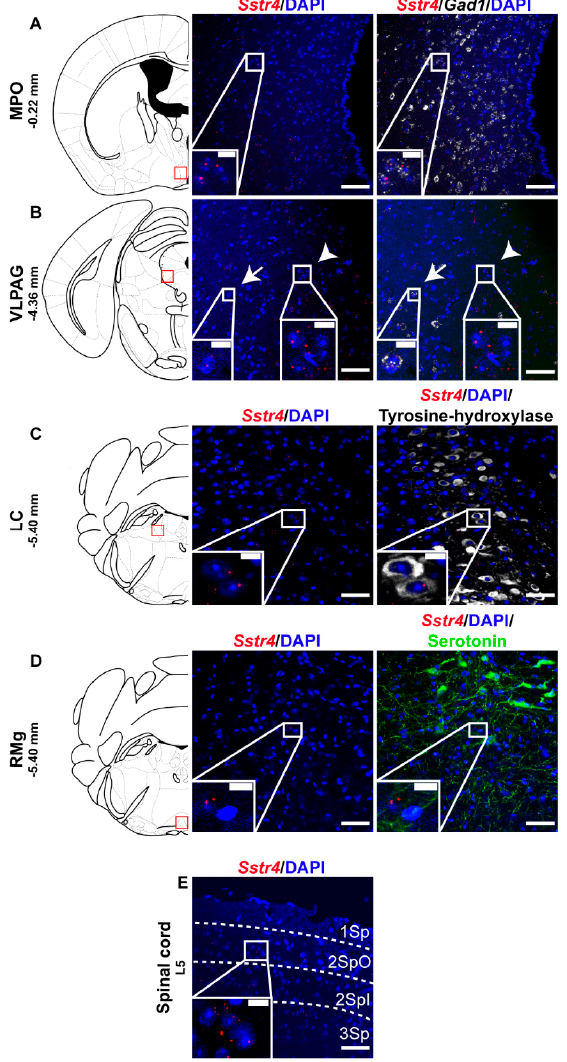
Figure 4. Representative Sstr4 expression in the descending anti-nociceptive system of WT mice. Sstr4 mRNA (red) counterstained with DAPI are shown in the medial preoptic area (MPO, Bregma − 0.22 mm, ( A )), in the ventrolateral periaqueductal gray matter (VLPAG, Bregma − 4.36 mm, ( B ), arrow marks Sstr4 co-localization with Gad1 , arrowhead points to Gad1 -negative Sstr4 expressing neurons), in the locus coeruleus (LC, Bregma − 5.40 mm, ( C )) co-localized with tyrosine-hydroxylase (TH)-immunoreactive noradrenergic cells (white) and in the raphe magnus nucleus (RMg, Bregma − 5.40 mm, ( D )) where Sstr4 does not co-localize with serotoninergic cells (green). Panel ( E ) represents Sstr4 mRNA expressing cells in the superficial layers (I–III) of the spinal dorsal horn. ( N = 2). Scale bar: 50 µm, inset scale bar: 10 µm.